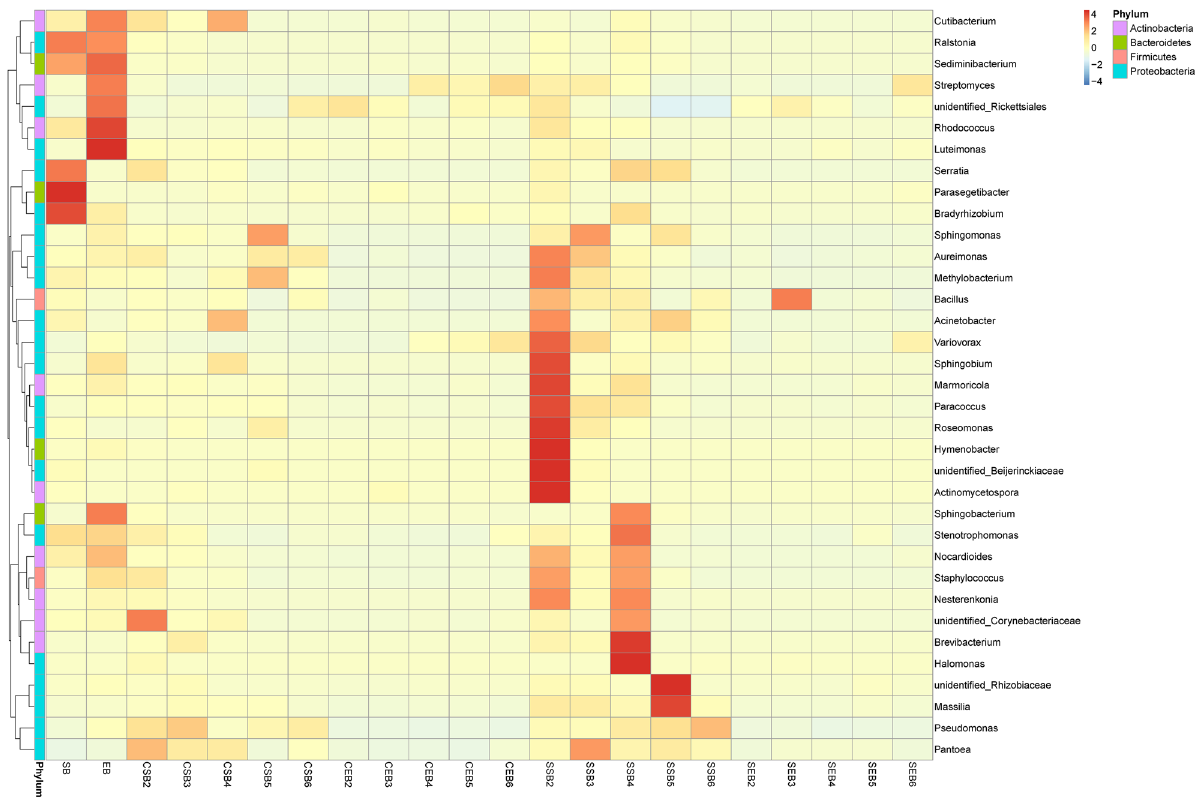
Figure 9. Clustered heat map of species abundances at the level of